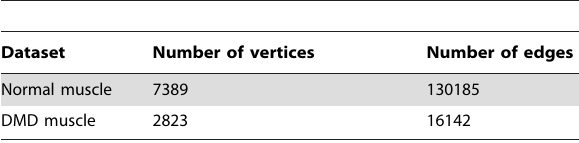
Table 3. Parameters of networks’ largest component used for community structure analysis.